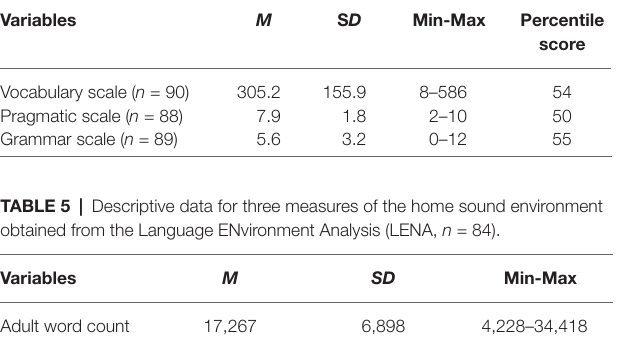
TABLE 4 | Descriptive data for three subscales of the Swedish Early Communicative Development Inventory – Words and Sentences (SECDI-2). Variables M S D